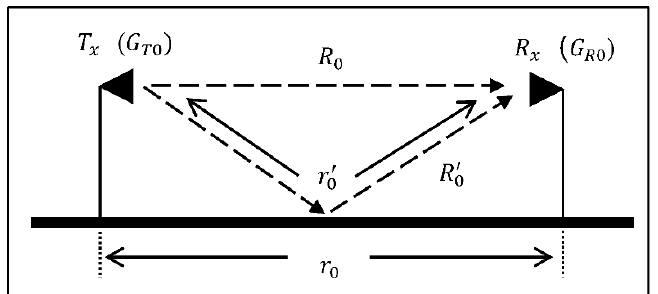
Figure 3. The two-ray model.